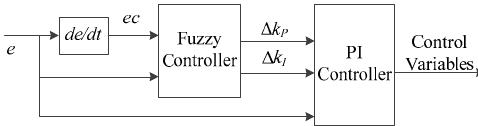
Figure 8. Structure of fuzzy adaptive PI controller.